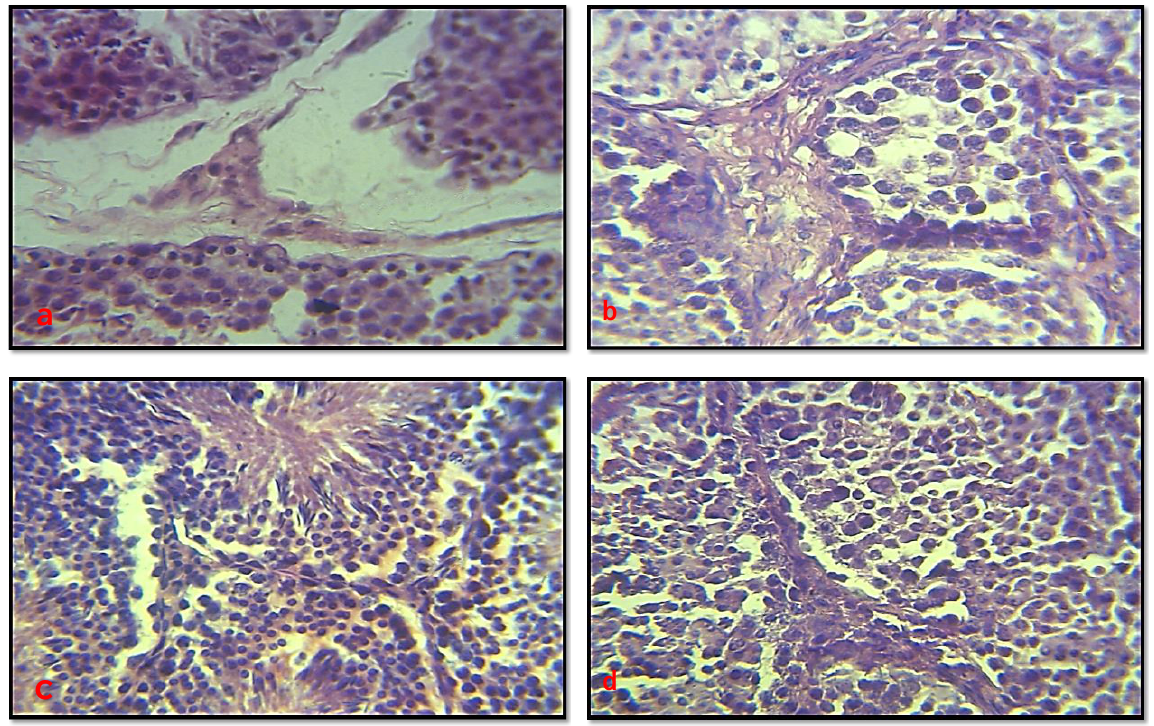
Figure, 1: Histopathological examination of testis rabbits (a) control group. (b) T1 group treated with 500mg/kg mixed with 0.5 ml of olive oil.(I.P) Twice daily. (c)T2 group treated with 100mg/kg PPE daily with 0.5 ml of olive oil.(I.P) Twice daily (d) T3 group treated with 100mg/kg PPE plus 500mg/kg CCl oil(I.P) Twice daily .After 56 day of